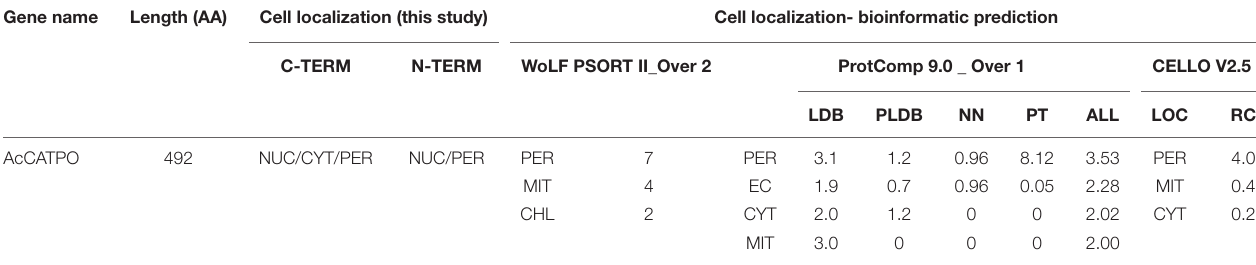
TABLE 2 | Comparison of targeting signals and subcellular localizations of AcCATPO predicted and N- and C-terminal GFP tagged.